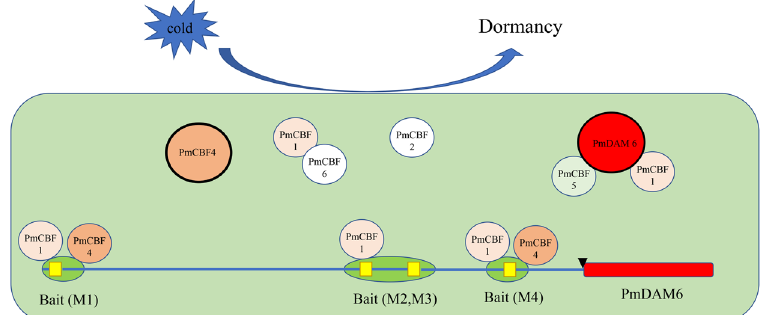
Figure 6. Molecular regulation model of PmDAMs and PmCBFs during flower bud dormancy. PmCBF4 and PmDAM6 could form homodimers, respectively (displayed in larger circles). PmCBF5 could form heteromeric complexes with PmDAM1 and PmDAM6. Meanwhile, PmCBF1 and PmCBF3 recognized the promoter of PmDAM6 by the binding site M2 and M3, PmCBF1 and PmCBF4 could discern M1 and